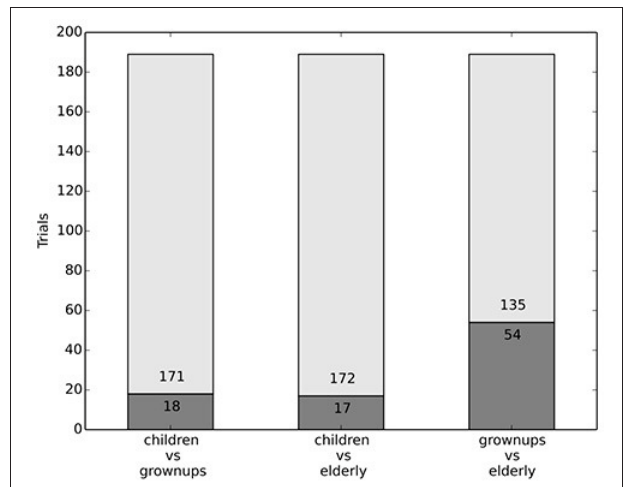
FIGURE 3 | Age of people is an important factor.